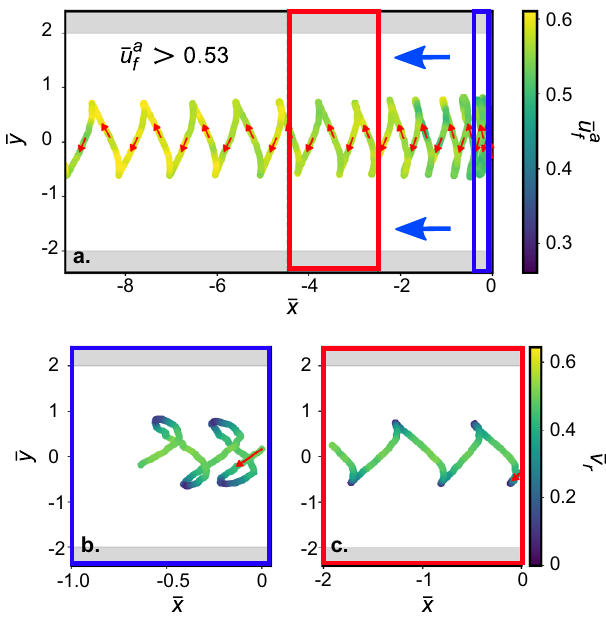
Fig. 2 Downstream drift of the active droplet for strong counter fl ow. a Swinging trajectory of the active droplet as it drifts downstream, with increasing (cid:2) u a f above a threshold value ( ≈ 0.53), colour coded by (cid:2) u a f , blue arrows marking the imposed fl ow direction. b , c Variation in (cid:2) v r over the swinging trajectory for increasing values of (cid:2) u a f ; coloured boxes correspond to data ranges in